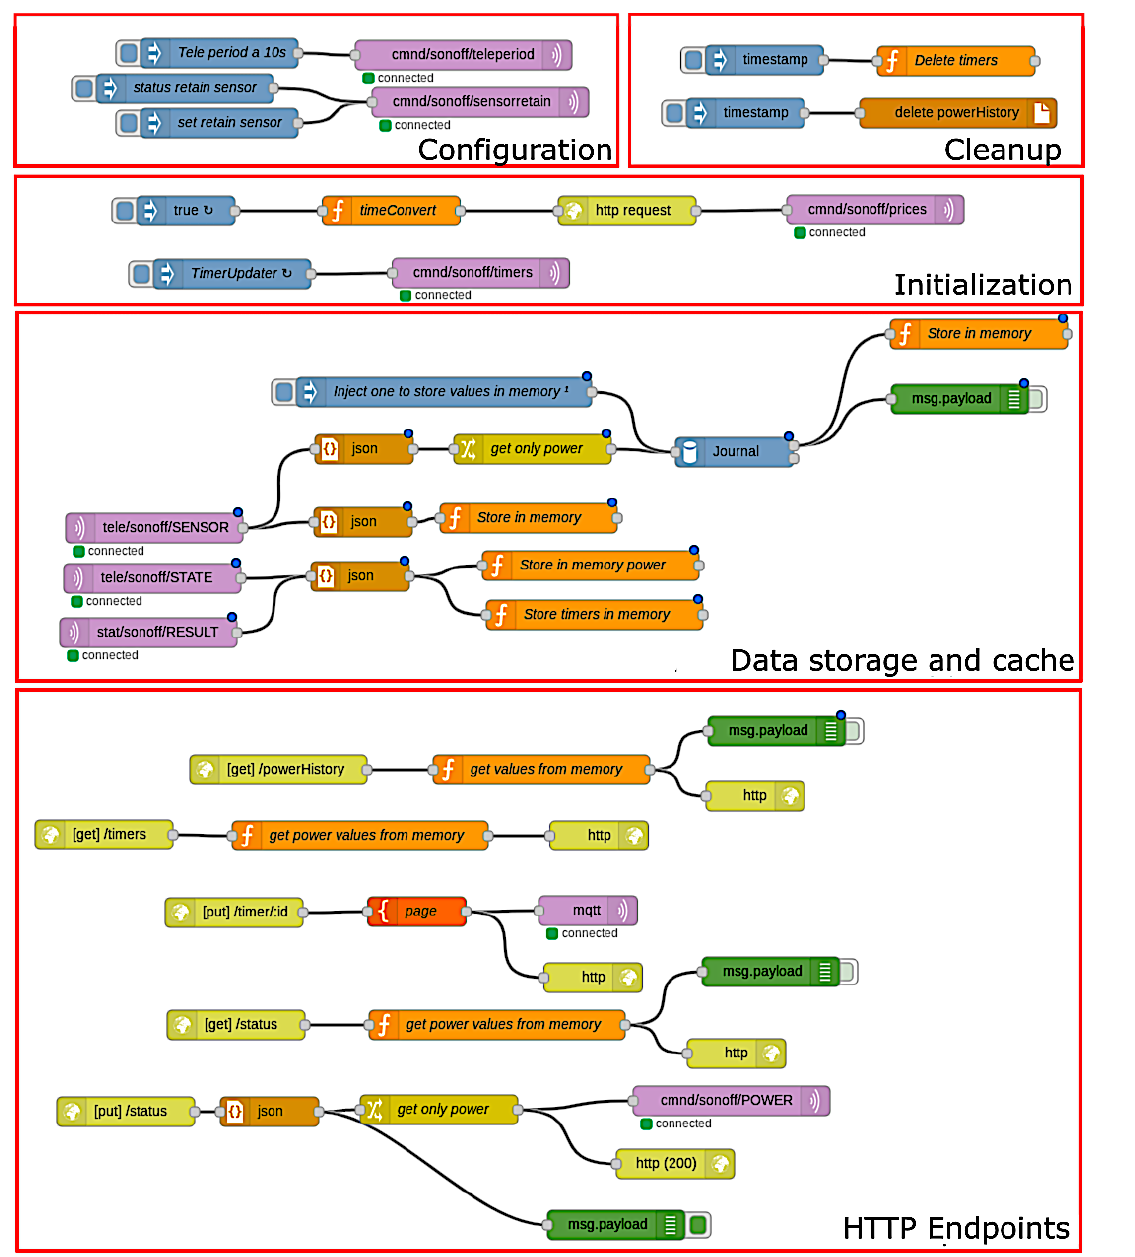
Figure 7. Screenshot of the data flows configured in